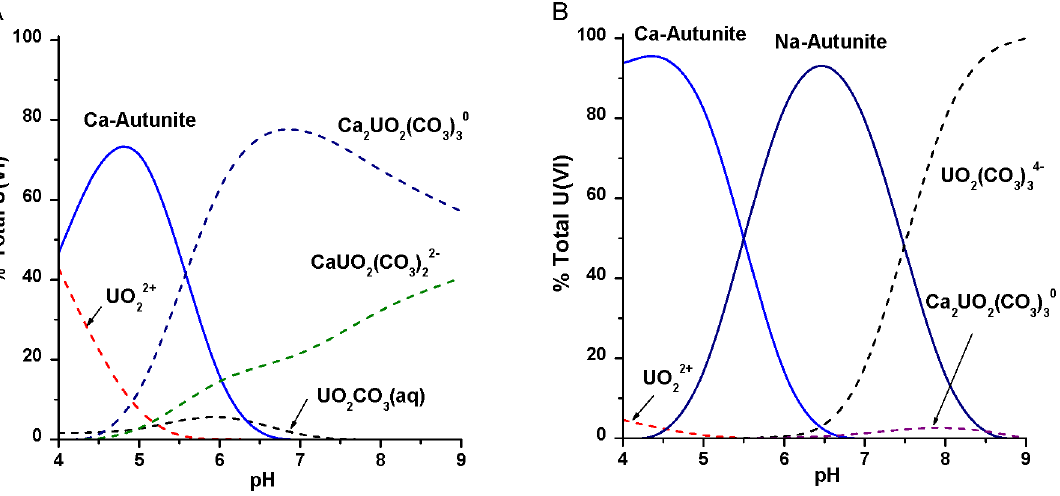
Figure 1. Thermodynamic modeling of U(VI) in the presence of phosphate as a function of pH. ORFRC Area 2 groundwater concentrations of dissolved ions (GW-836 monitoring well), U(VI)=4.5 m M, Ca 2 + =4.85 mM, (A) PO 43 2 =500 m M and (B) PO 43 2 =5 mM were used to model the distribution of U(VI) species. Dashed lines represent soluble species and solid lines represent insoluble species.